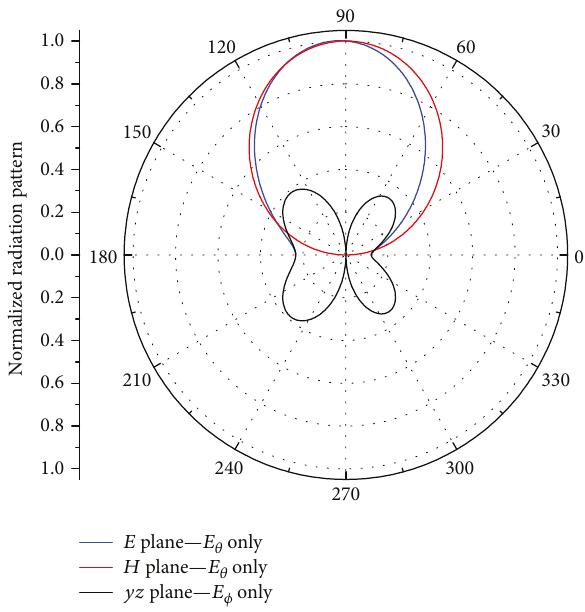
Figure 7: Normalized radiation pattern of the HB